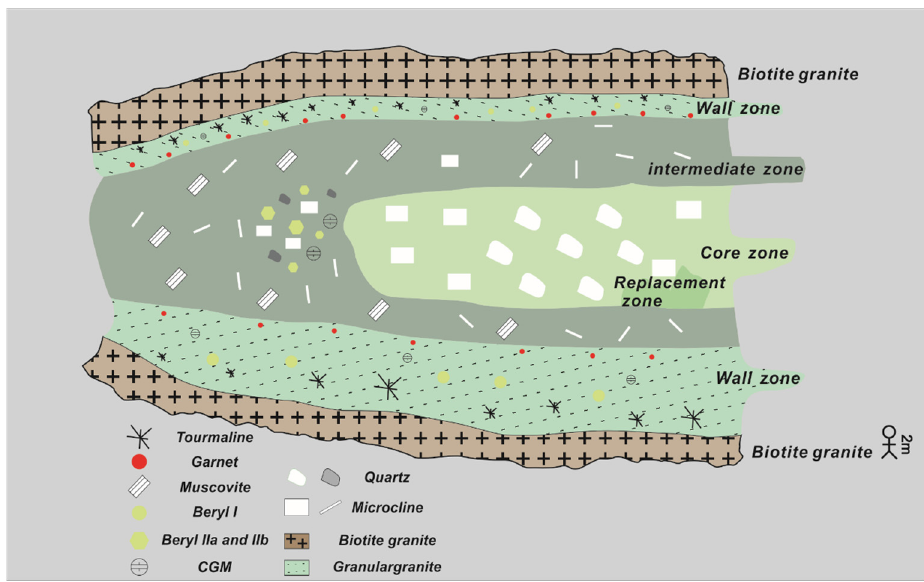
Figure 4. Schematic diagram of the Dakalasu No.1 pegmatite.